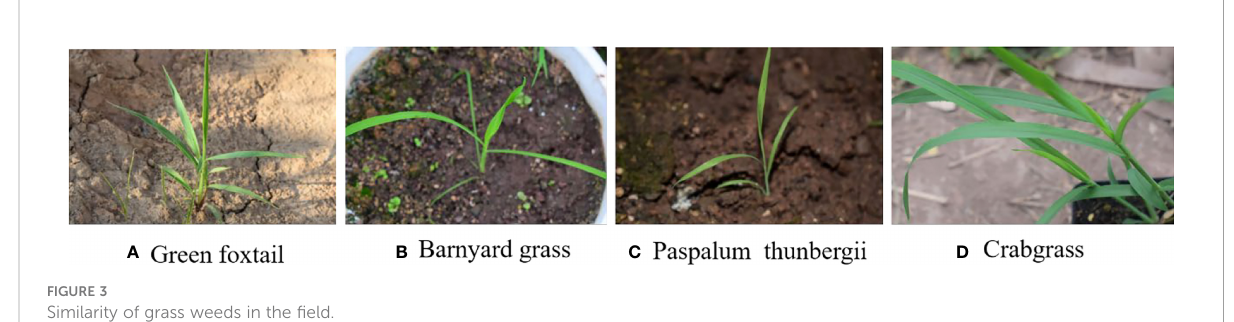
FIGURE 3 Similarity of grass weeds in the fi